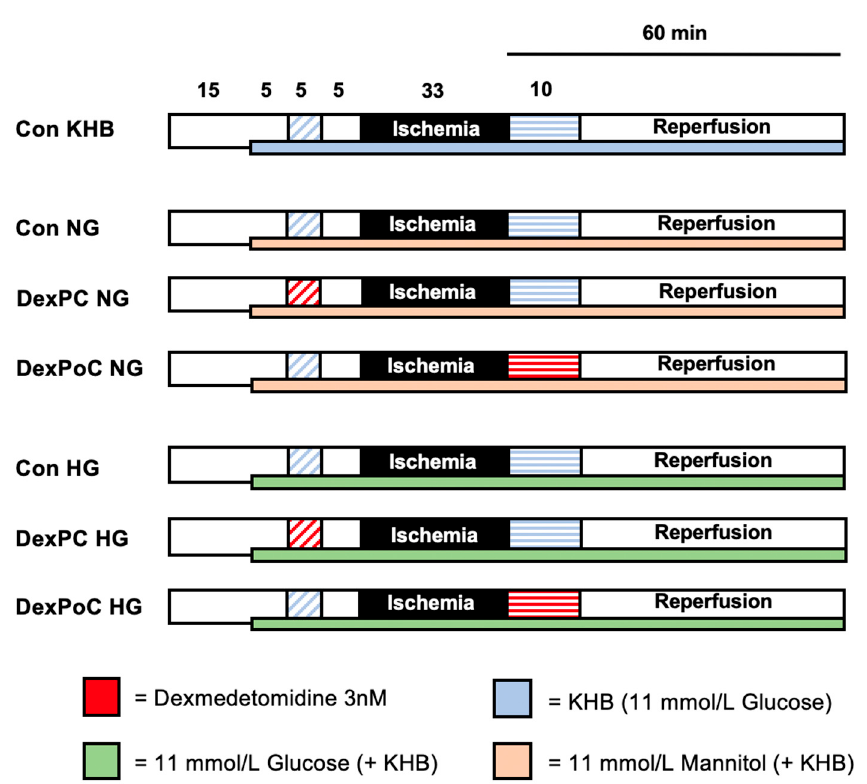
Figure 1. Experimental protocol. Con = Control; KHB = Krebs-Henseleit buffer, NG = Normoglycemia, HG = Hyperglycemia; Dex = Dexmedetomidine; PC = Preconditioning; PoC = Postconditioning.